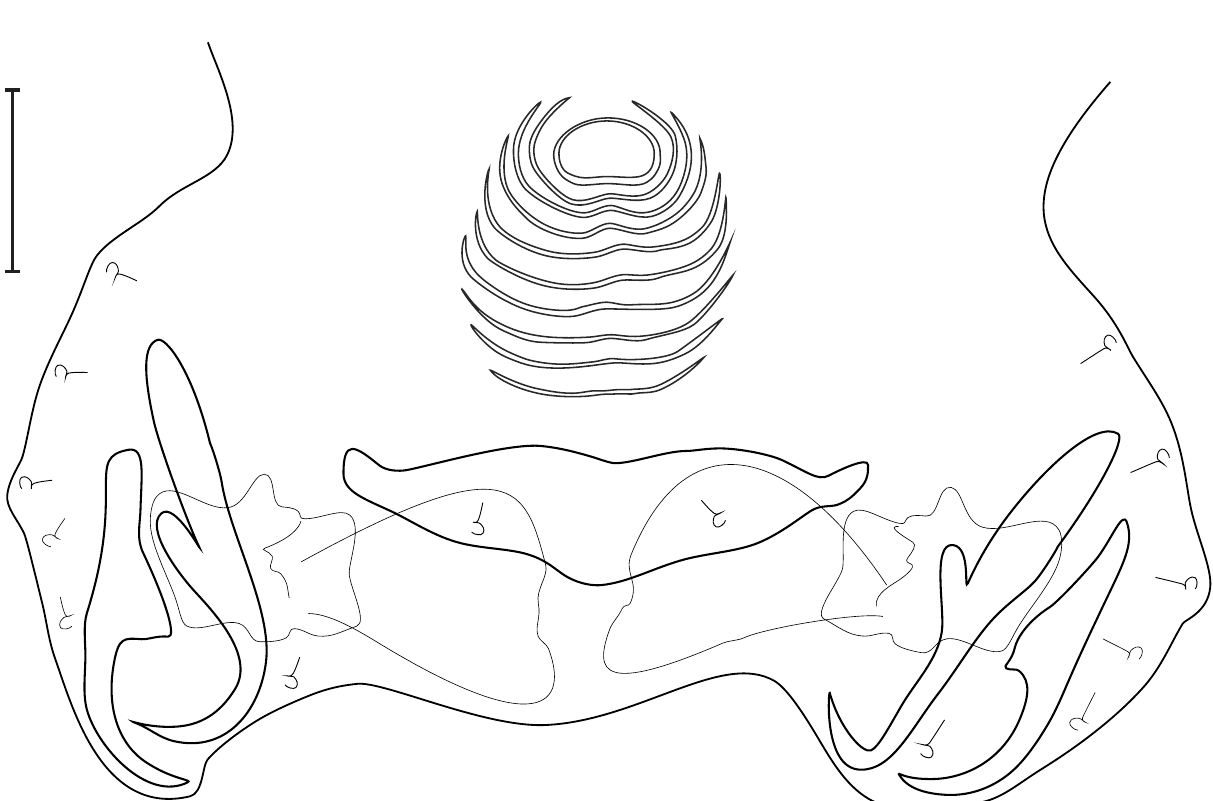
Fig. 2. – Lamellodiscus sanfilippoi n. sp. Morphologie du hapteur (vue ventrale). Échelle : 250